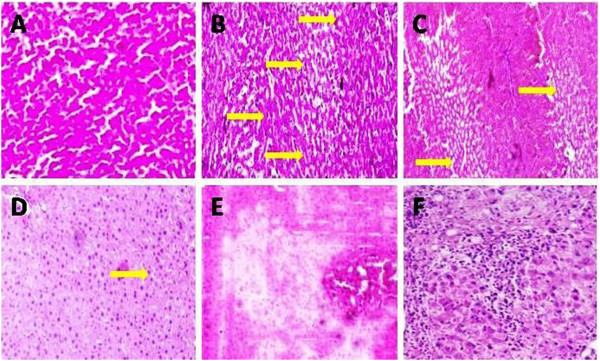
Paederia Foetida Linn. leaves extract effect on liver histopathology in normal and STZ induced diabetic rats. (A) Normal control: Histopathology of normal control rat did not display any sign of the changes (B) Diabetic control: Yellow arrow display the deposition of the fat micro and macro droplet. (C)PF I (100 mg/kg): STZ induced diabetic rat display the micro droplet deposition on the liver histopathology (Yellow arrow) (D)PF II (250 mg/kg): PF increasing dose display the few micro droplet deposition of the fats (Yellow arrow) (E)PF III (500 mg/kg): PF dose 500 mg/kg did not display any change or absorbent. (F) Glibenclamide (10 mg/kg): Glibenclamide treated group rat display the normal histopathology. The samples were obtained from the same liver anatomical regions. For each group, 6 rats were examined and 80 pictures were taken. The above picture for each group was chosen randomly from the 50 pictures in this group. Original magnification, 10×.